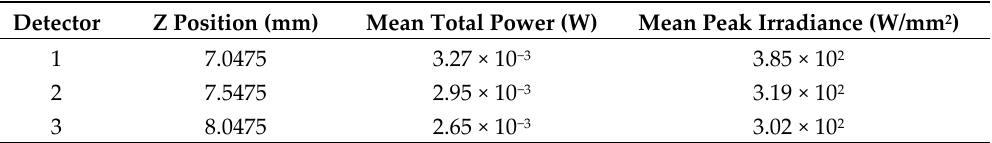
Table 4. Simulation